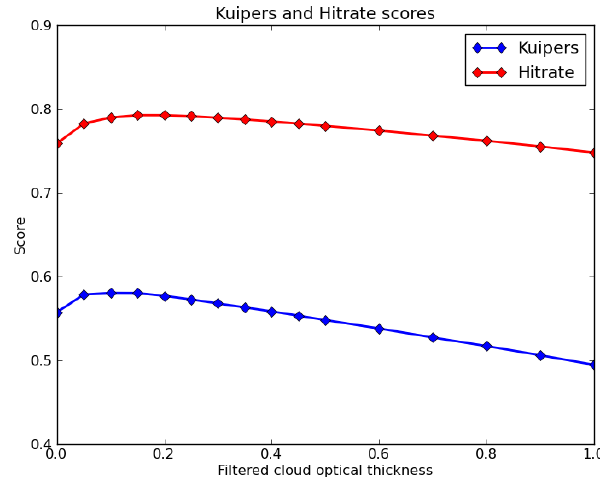
Fig. 5. Same visualisation as in Fig. 4 but for probability of detec- tion (POD) and false alarm rates (FAR) for cloudy and clear cate- gories.